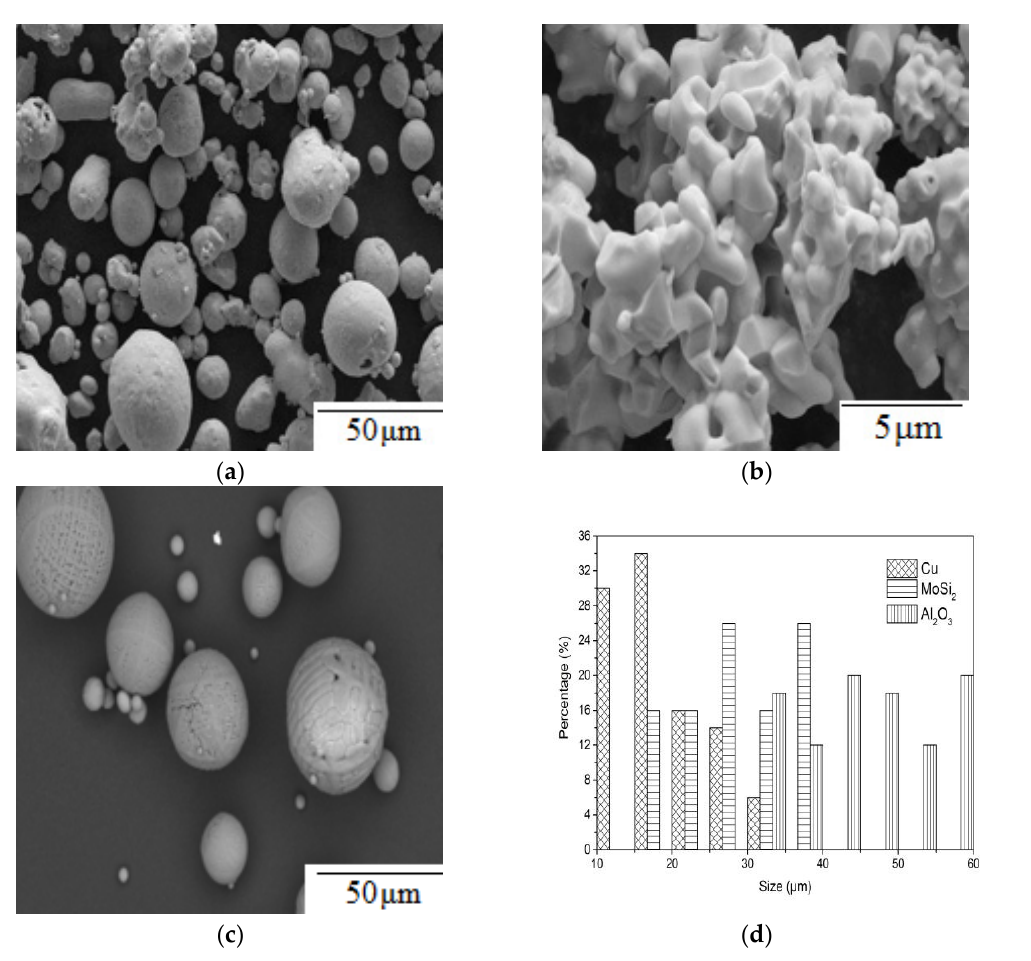
Figure 1. Three-elements distribution on the upper surface of the Al 2 O 3 –MoSi 2 /Cu coating and feedstock: ( a ) Cu; ( b ) MoSi 2 ; ( c ) Al 2 O 3 ; ( d ) the corresponding particle size distribution histograms of the Cu, MoSi 2 , and Al 2 O 3 particles.